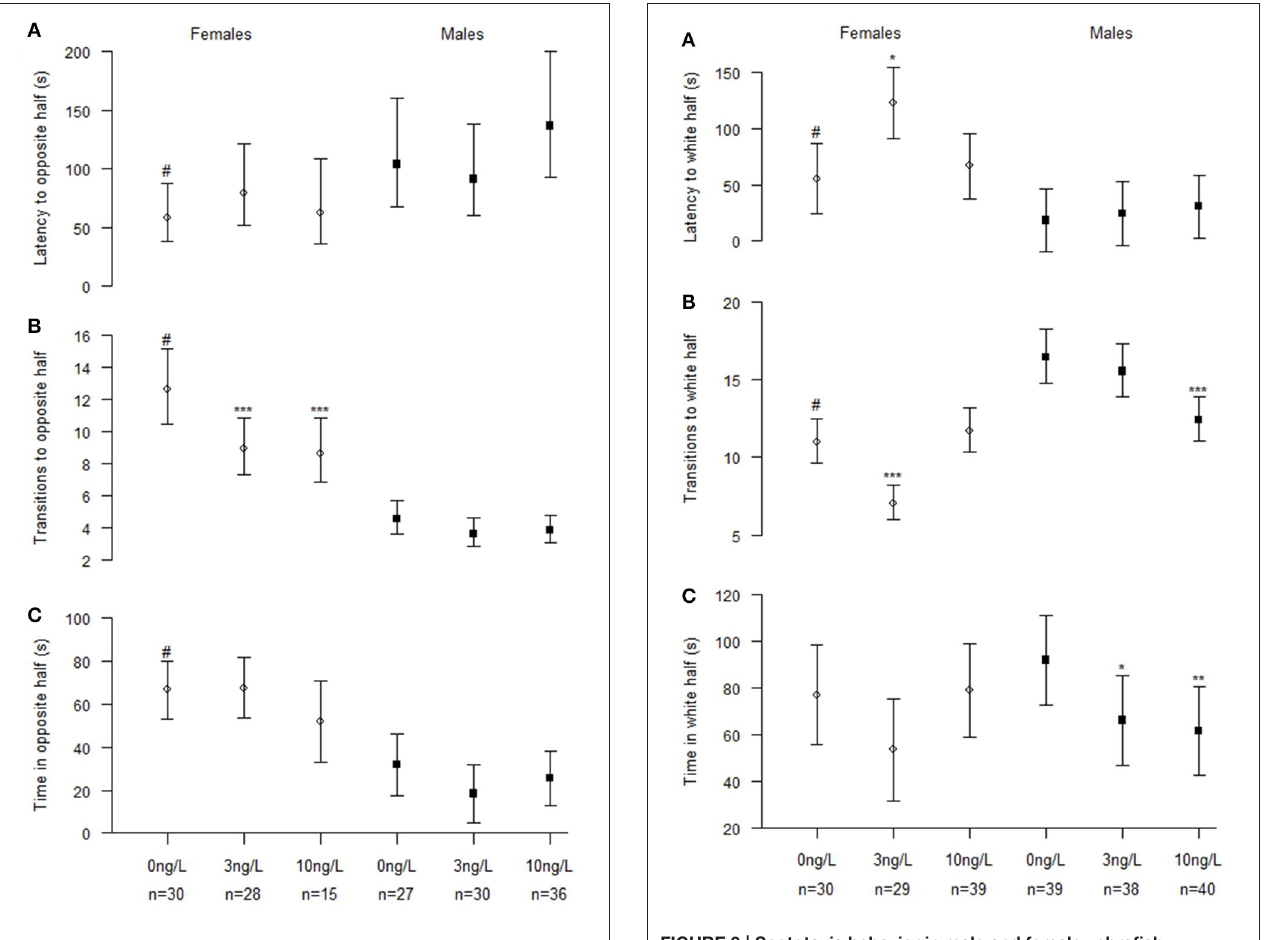
FIGURE 2 | Shoaling behavior in male and female zebrafish developmentally exposed to 0, 3, or 10ng/L EE 2 and remediated in clean water for 120 days. (A) Latency time before leaving shoal (crossing the vertical midline), (B) Number of transitions to the opposite half and (C) Total time spent in the opposite half. Data represent mean ± 95% CI, # p < 0.05, *** p < 0.001. *Significantly different from control fishes of the same sex, # control females significantly different from control males.